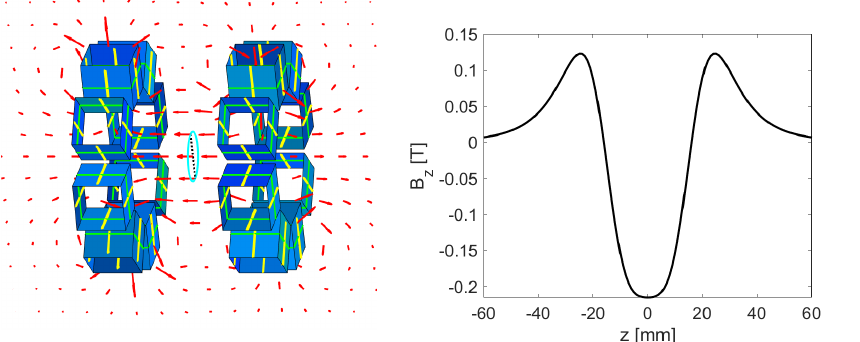
Figure 5. Left: a radial solenoid made of two rings and the field illustrated by the red arrows. Right: the axial field B z along a line through the center of the two